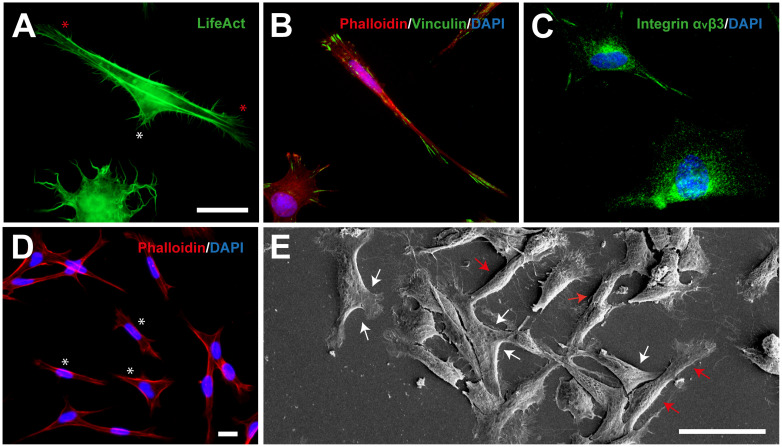
TEG3 cytoskeletal dynamics and phenotype morphology. (A) Lentiviral transfected LifeAct-eGFP TEG3 showing a high expression of membrane protrusions through the presence of motile lamellipodia; trailing process (white asterisk) and in the cell body (red asterisk); (B) intracellular distribution of F-actin and focal adhesions (FAs) on laminin substrate; (C) stain of integrin αvβ3; (D) flattened TEG3 cells showing membrane protrusion on one or both sides; and (E) FESEM image of a mix of bipolar (Schwann-type OECs, red arrows) and flattened (astrocyte-type OECs, white arrows) cells under in vitro conditions. Scale bars (A–C) – 10 μm; (D) – 10 μm; and (E) – 50 μm.